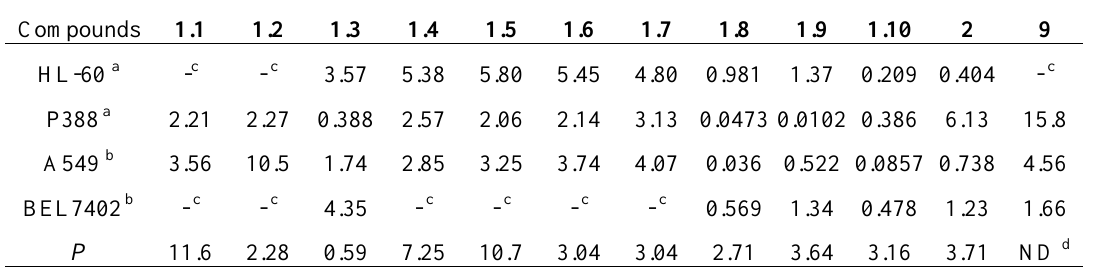
Table 1 . Cytotoxic Activity of 1.1 - 1.10 in vitro ( IC